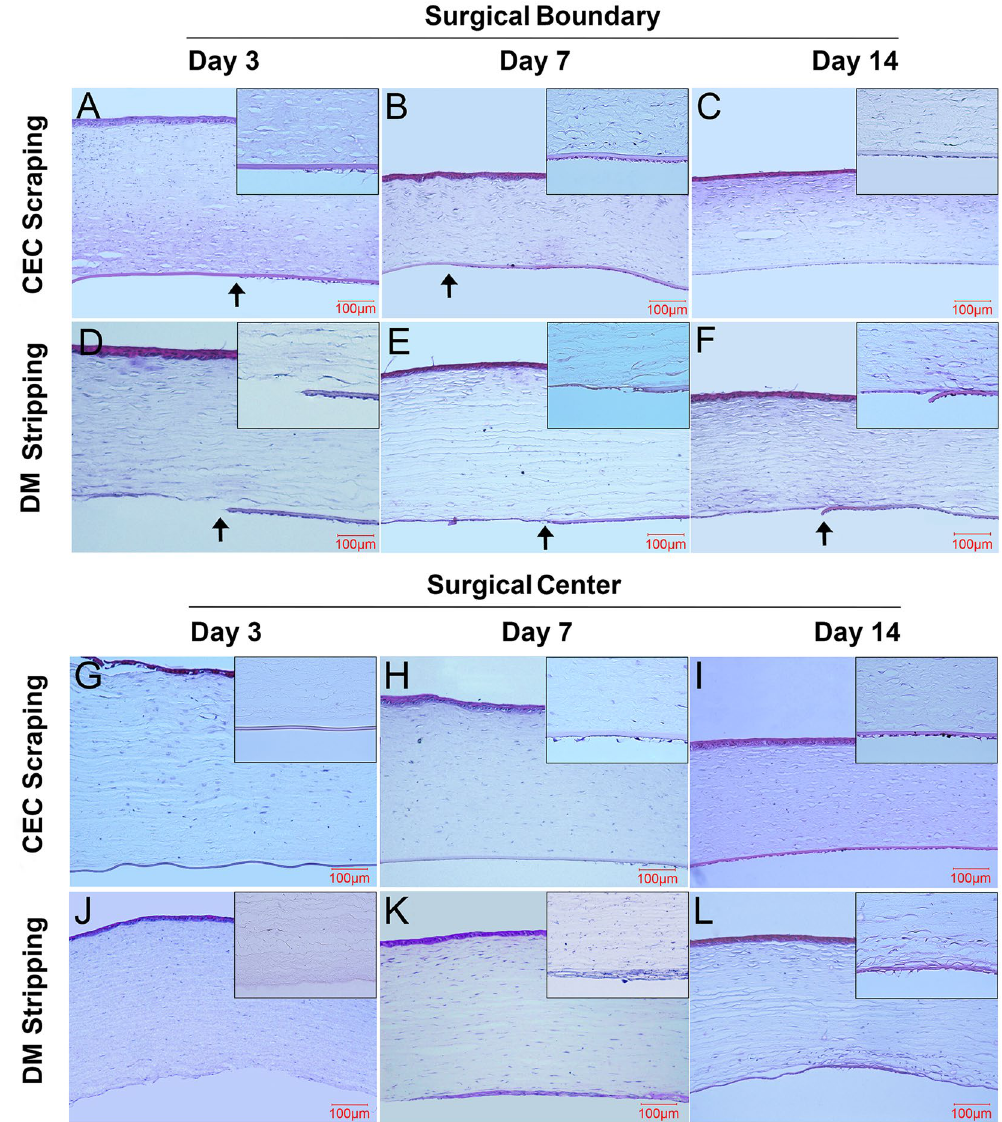
Figure 4. H&E staining of the corneal tissues after endothelial injury. The DM was intact in the CEC scraping group, and a leading edge of CECs was detectable on day 3 ( A , arrow) and day 7 ( B , arrow) but vanished on day 14 ( C ). The DM stripping cornea showed a clear border of DM removal on day 3 ( D , arrow), day 7 ( E , arrow), and day 14 ( F , arrow). In the central cornea, the DM was denuded on day 3 in CEC scraping rabbits ( G ), and there were few cells on the DM surface on day 7 ( H ), while the DM was covered by cells on day 14 ( I ). In the DM stripping rabbits, the central cornea showed a rough surface without the DM on day 3 ( L ) and was covered with a membranous tissue on day 7 ( M ), which remained on day 14 ( N ). Bars represent 100 μ